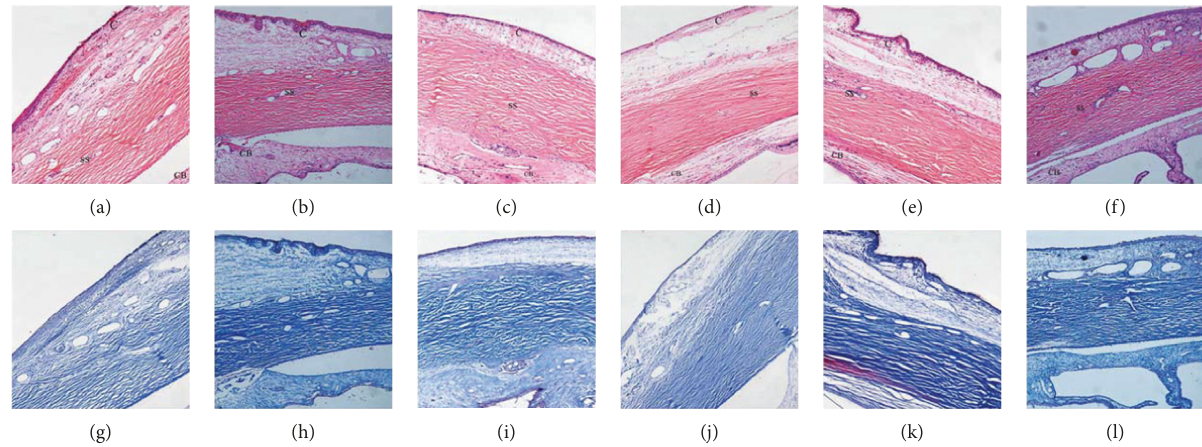
Figure 7: Histological features of filtering positions after 56 days (magnification ratio × 100). (a–f) Hematoxylin and eosin (H&E) staining, (g–l) Masson staining of the tissue sections. In the control (a and g) and 5-fluorouracil (5-Fu) treatment groups (c and i), the subconjunctival fibrous scar tissues were dense. The collagen deposition was relatively loose in the bevacizumab (BVZ) treatment group (b and h), and the structures of filtering blebs could not be distinguished in the three groups. In the mitomycin C (MMC) (d and j), 5-FU +BVZ (e and k), and MMC+BVZ (f and l) treatment groups, the subconjunctival collagen deposition was spare, and the residual filtering bleb structure was observed in all these groups. CB, ciliary body; C, conjunctiva; SS, scleral excision